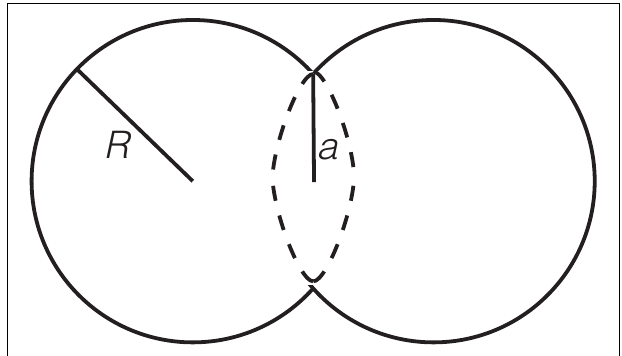
FIGURE 1 | A shematic view of two spherical grains of radius R are in contact by an area of radius a .